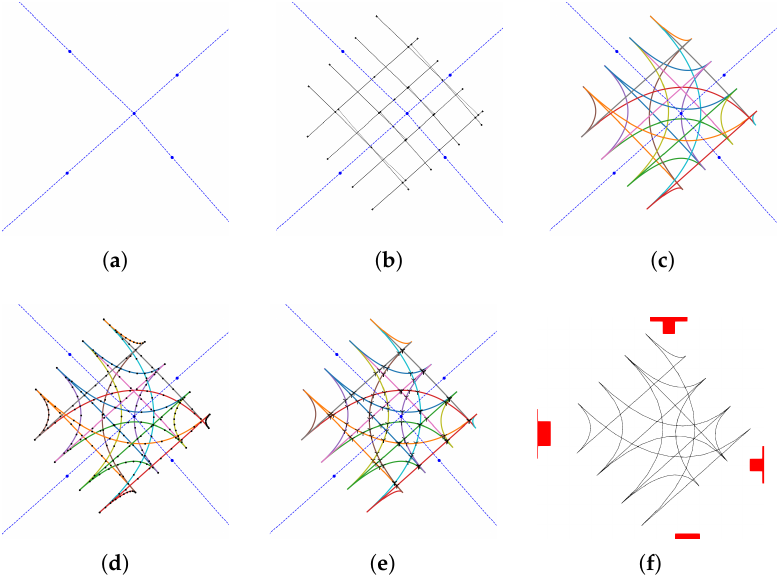
Figure 4. Main steps involved in automated construction of car trajectories at junctions: ( a ) Road center lines (input), ( b ) B-spline control net, ( c ) B-spline model of vehicle trajectories, ( d ) Points on the B-splines for piece-wise linear approximation, ( e ) Approximate intersecting points of B-splines, ( f ) Piece-wise linear approximations of B-splines shown with the grid.